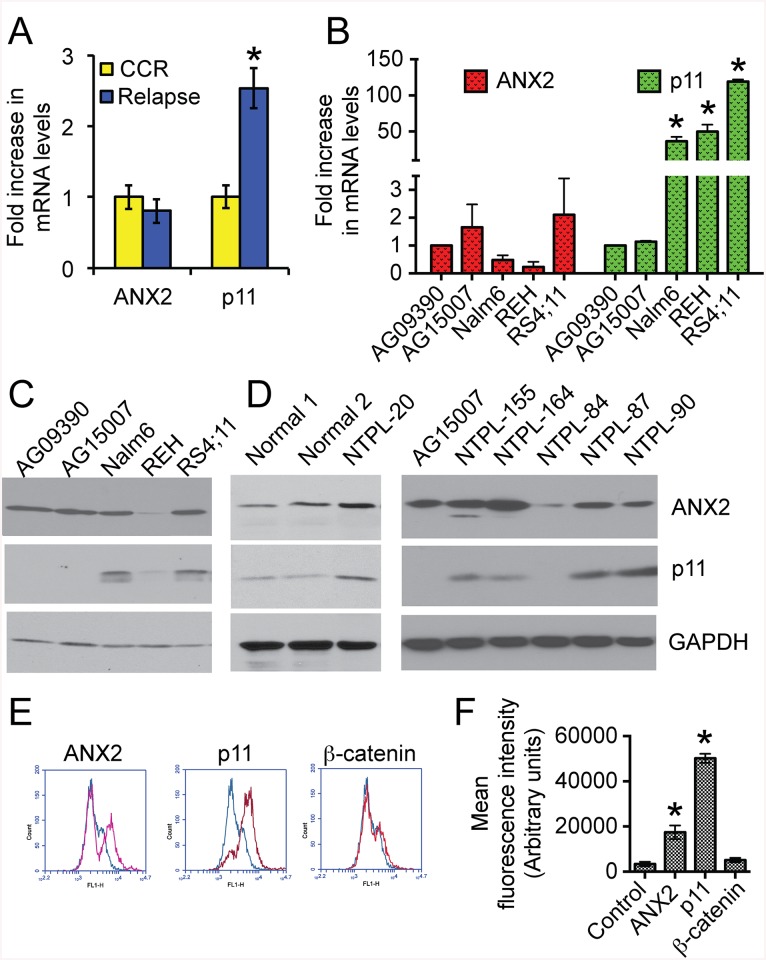
p11 is upregulated at mRNA and protein levels and is localized to the cell surface in ALL cells.
A) Analysis of microarray data from GSE7440 showing fold-increase in transcript levels of ANX2 and p11. CCR = patients under continuous complete remission for more than four years (n = 28). Relapse = patients who relapsed within three years of initial diagnosis (n = 31). Error bars denote Standard Deviation (SD) of the Mean. Asterisk indicates statistical significance with a confidence limit of 95%. B) Quantitative RT-PCR data showing mRNA levels of ANX2 and p11 in pediatric normal immortalized B-cells (AG09390 and AG15007) and pediatric (Nalm6, REH) or adult (RS4;11) pre B-ALL cell lines. Error bars denote SD of the Mean from four independent experiments. Asterisks indicate statistical significance with a confidence limit of 95%. C) Immunoblots showing ANX2 and p11 levels in the indicated cell lines. GAPDH was used as a loading control. Representative blots from three independent experiments are shown. D) Representative immunoblots showing ANX2 and p11 levels in lysates from mononuclear cells isolated from healthy volunteers (Normal 1 and 2), or from leukemic cells from pediatric patients. Samples were collected using IRB approved protocols. E) Flow cytometry profiles of fixed, non-permeabilized RS4;11 cells incubated with (red trace) or without (blue trace) addition of the indicated primary antibodies. F) Mean fluorescence intensity was plotted from three independent experiments. Error bars denote SD of the Mean. Asterisks indicate statistical significance (P < 0.01).